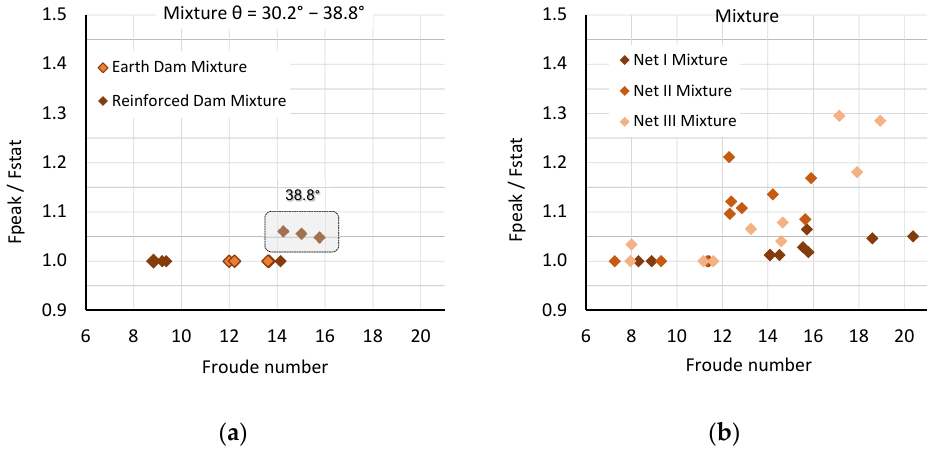
Figure 13. F peak / F stat as a function of the barrier and the Froude number for ( a ) Dam and ( b ) Nets. Test results in the frame in Figure 13 ( a ) for the inclination of 38.8 ◦ .